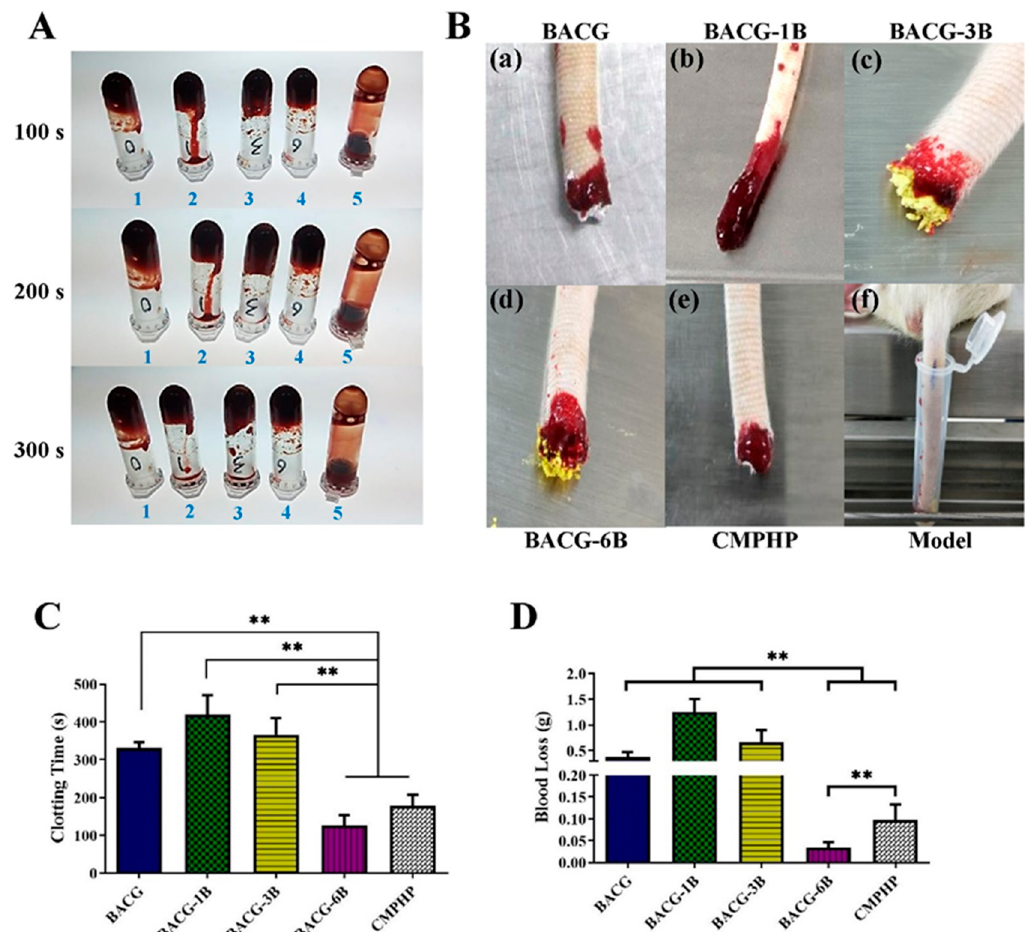
Figure 4. ( A ) Determination of clotting time in vitro. (#1–5) Compound microporous polysaccharide hemostatic powder (CMPHP), BACG-1B, BACG-3B, BACG-6B, blank control (BC) ( n = 3); ( B ) photographs of hemostatic performance ( a – e ) BACG, BACG-1B, BACG-3B, BACG-6B, CMPHP, and ( f ) model of hemostasis in rats; ( C ) clotting time; ( D ) blood loss (mean ± SD, ** p < 0.01, * p < 0.05, n = 6).